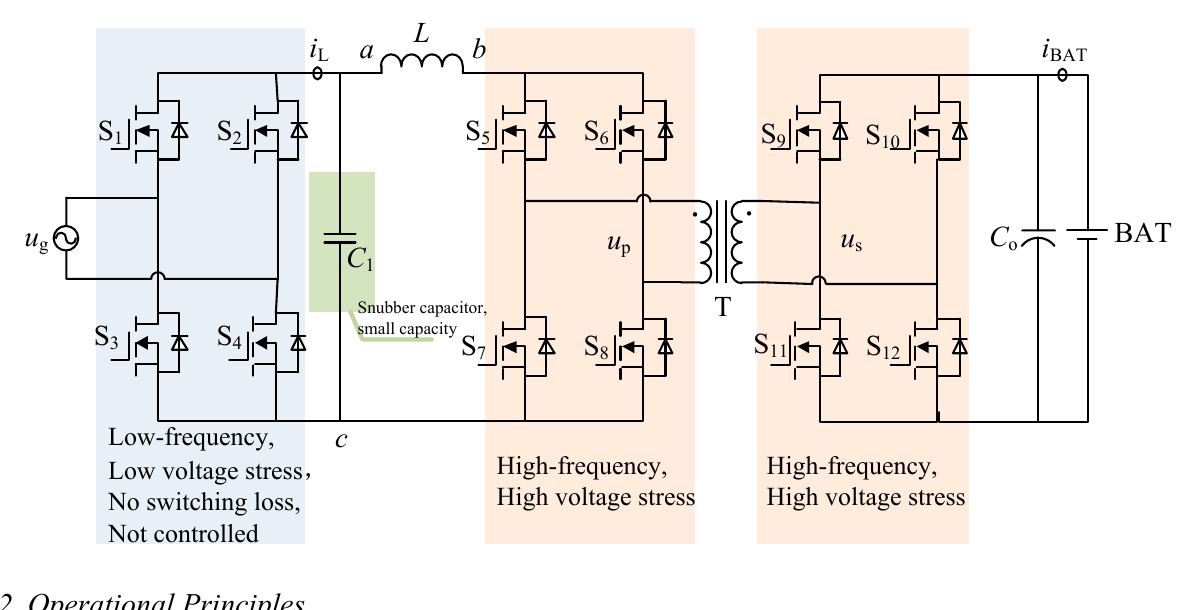
Figure 9. Topology of novel bidirectional single-stage full-bridge